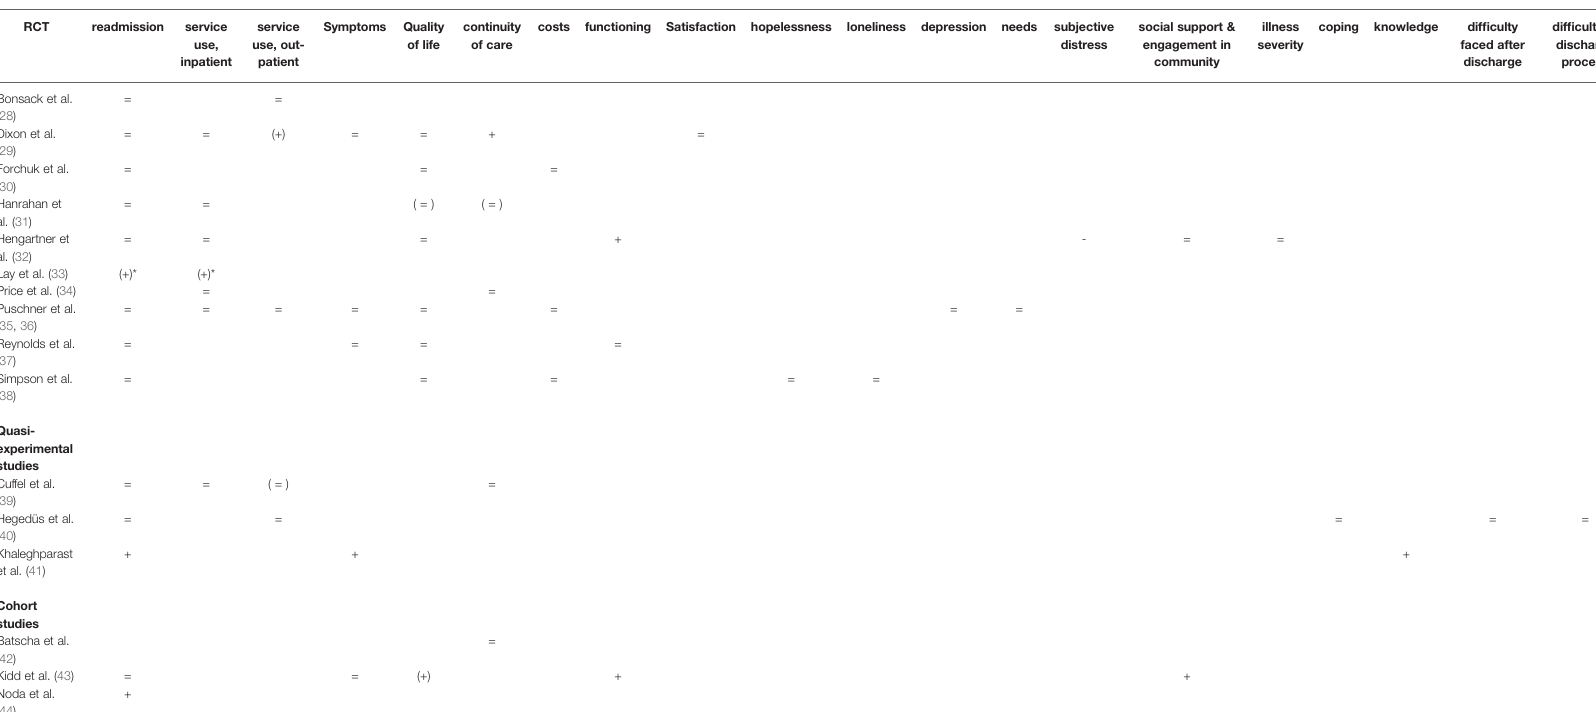
TABLE 4 | Overview of study